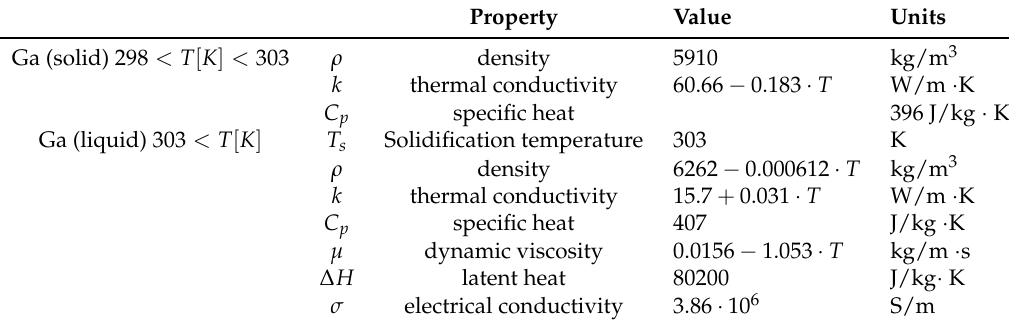
Table 1. Gallium thermophysical properties